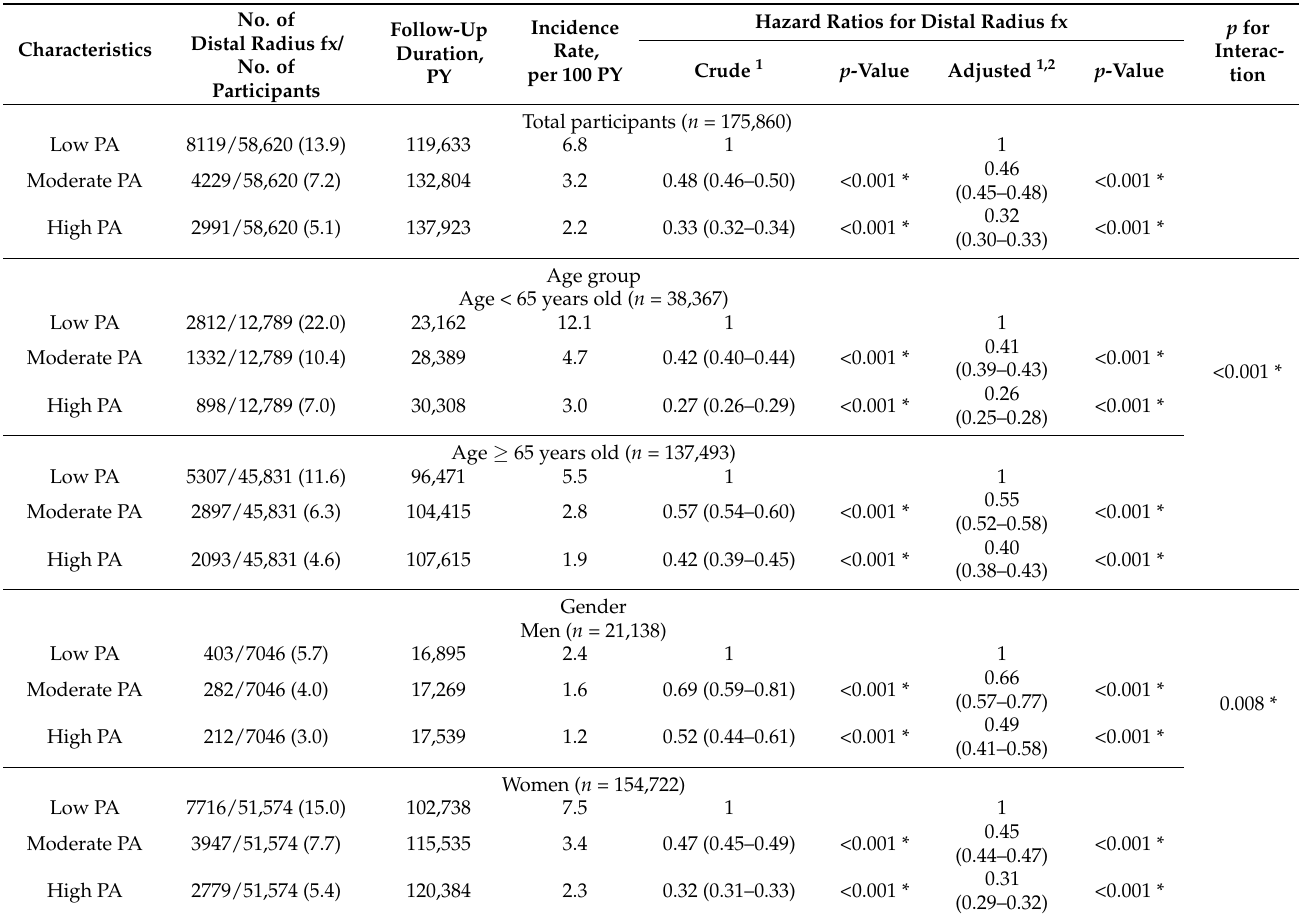
Table 4. HR (95% CIs) for distal radius fx in the PA groups with subgroup analyses according to age and